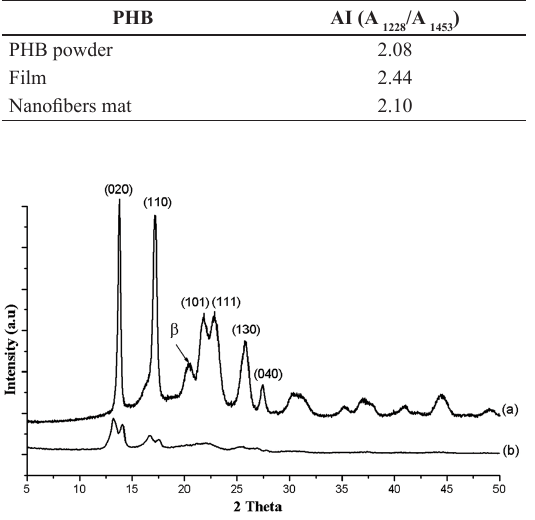
Figure 3. WAXD intensity profiles of PHB in: (a) thermo-compression molded film and (b) electrospun nanofibers mat. The diffraction planes associated with α crystalline form are indexed. The peak at around 2θ=200 indicates the presence of β crystalline